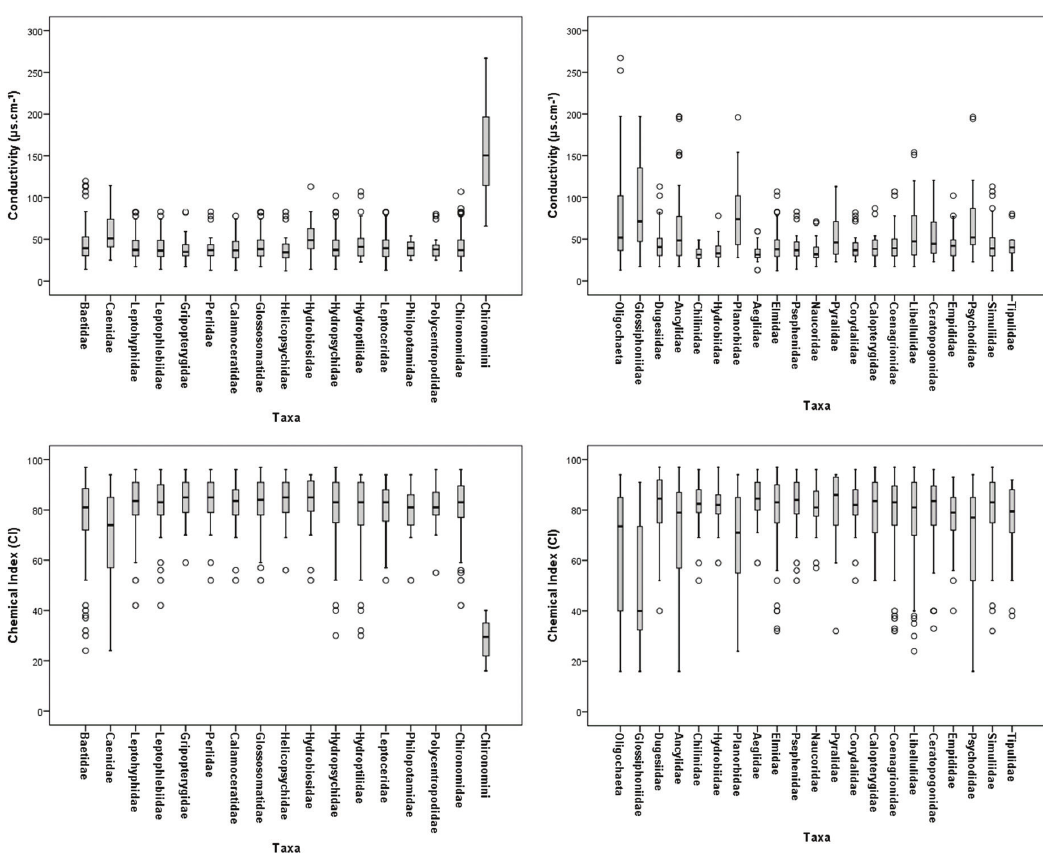
Figure 3. Ocurrence of 38 macroinvertebrate taxa in the amplitude of conductivity and Chemical Index in 35 lotic ecosystems of the northeast region of Rio Grande do Sul,